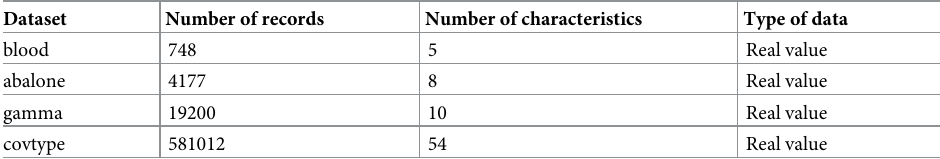
Table 1. Datasets used in the